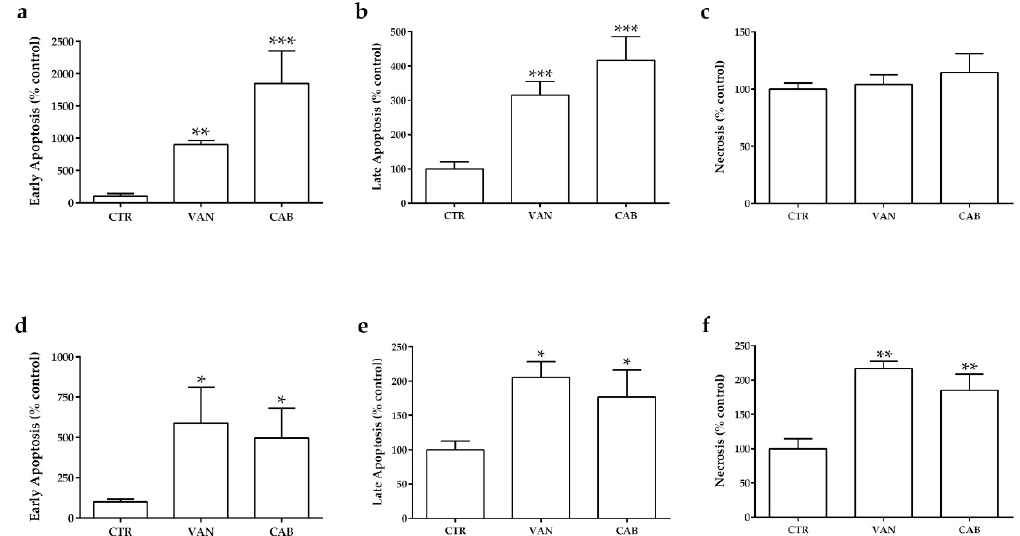
Figure 3. Effects of vandetanib (VAN) and cabozantinib (CAB) on apoptosis in medullary thyroid carcinoma (MTC) cell lines. Cell death analysis after six days of incubation with VAN and CAB in TT ( a – c ) and MZ-CRC-1 cell lines ( d – f ) through flow cytometry with Annexin V and propidium iodine. The proportions of cells in early apoptosis ( a , d ), late apoptosis ( b , e ) and necrosis ( c , f ) were expressed as the percentage compared with the untreated control (CTR) and represent the mean ± S.E.M. of at least three independent experiments. * p < 0.05; ** p < 0.01; *** p < 0.001.